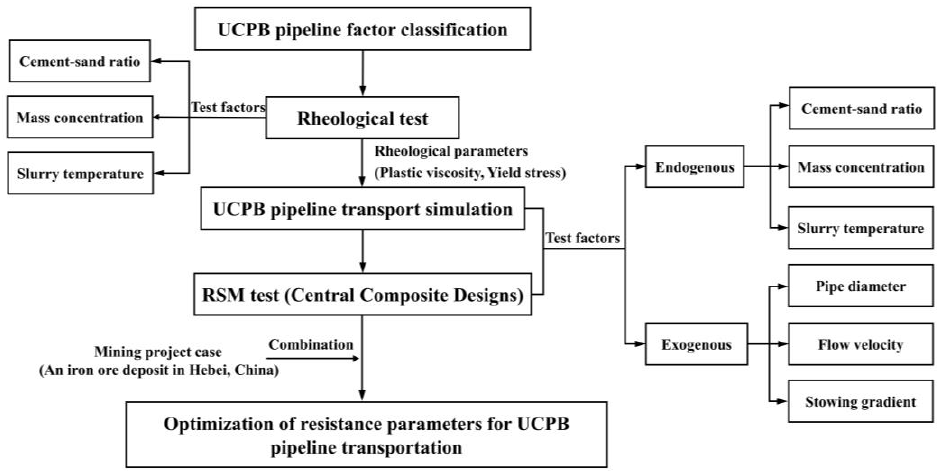
Figure 6. Experimental flow chart.